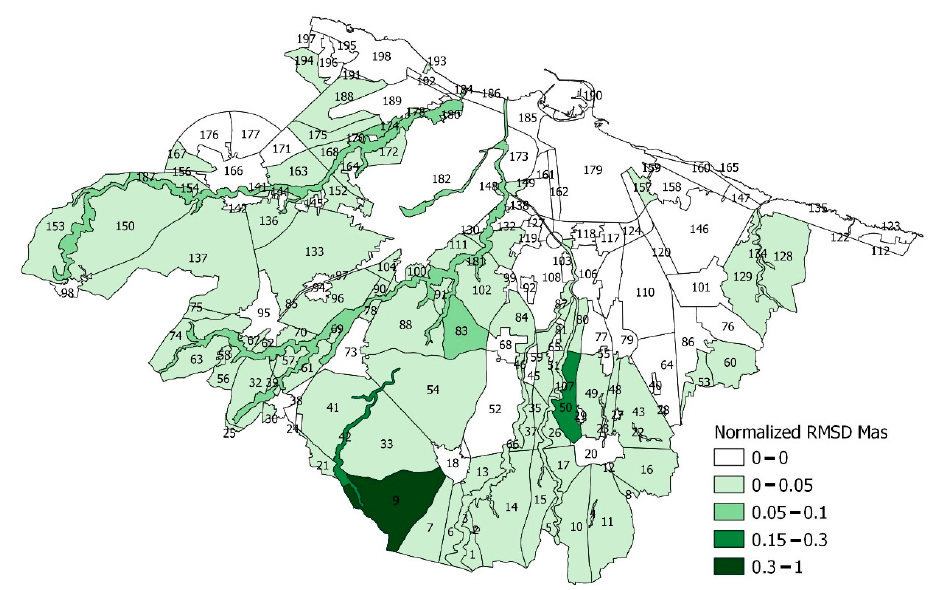
Figure 9. Effects of the four (Land Use/Land Cover) LULC class aggregation on Bio-Energy Landscape Connectivity at BELU level: Normalized Root Mean Square Deviation (NRMSD) of asymptotic M.